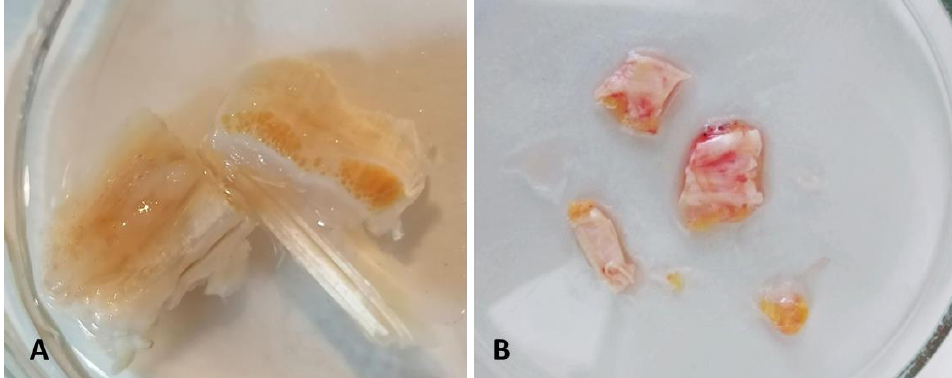
Figure 1. ( A ) 1 cm × 1 cm samples for histological and immunohistochemistry examinations after isolation were immediately fixed in formalin. ( B ) 1 cm × 1 cm TL fasciae were cut into small pieces, immediately snap-frozen in isopentane on dry ice, and then stored in liquid nitrogen in the institu- tional tumor bank for total ribonucleic acid (RNA) extraction, gene expression analysis and im-